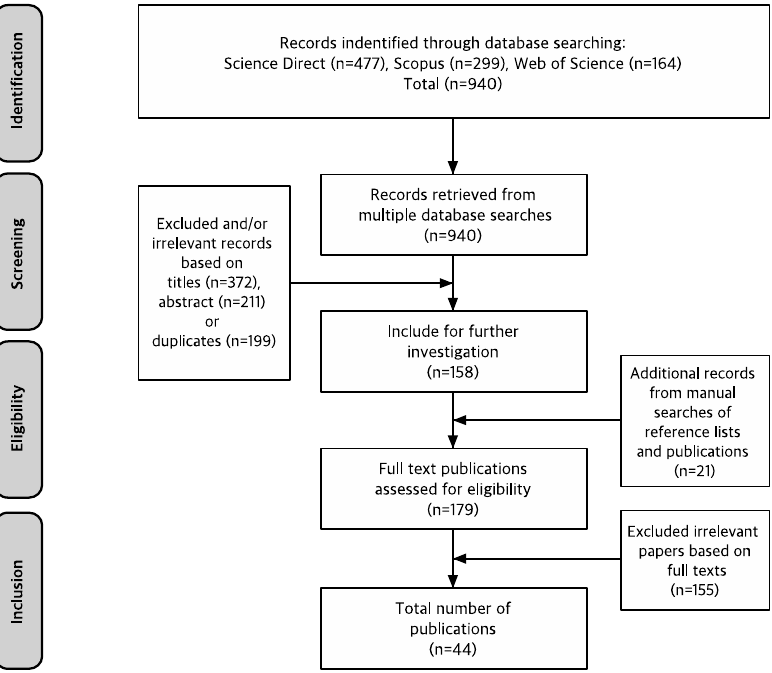
Figure 1. Flow diagram of the screening method to consider journals for inclusion in this literature review .